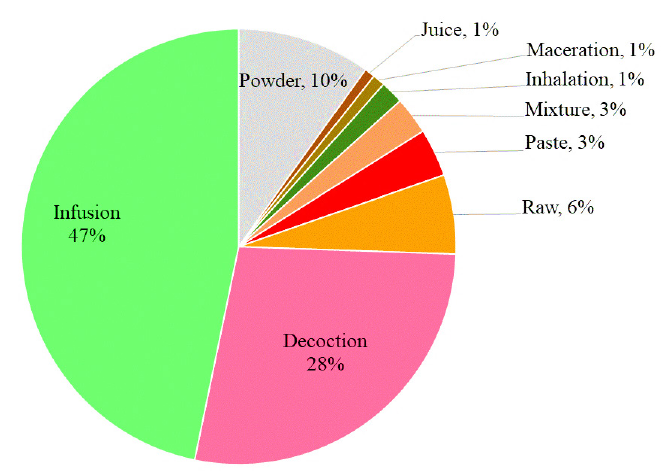
Figure 4. Modes of preparation of the reported ethnomedicinal plant